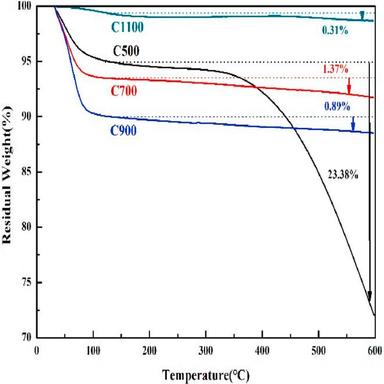
The TGA curves of C500, C700, C900, and C1100.